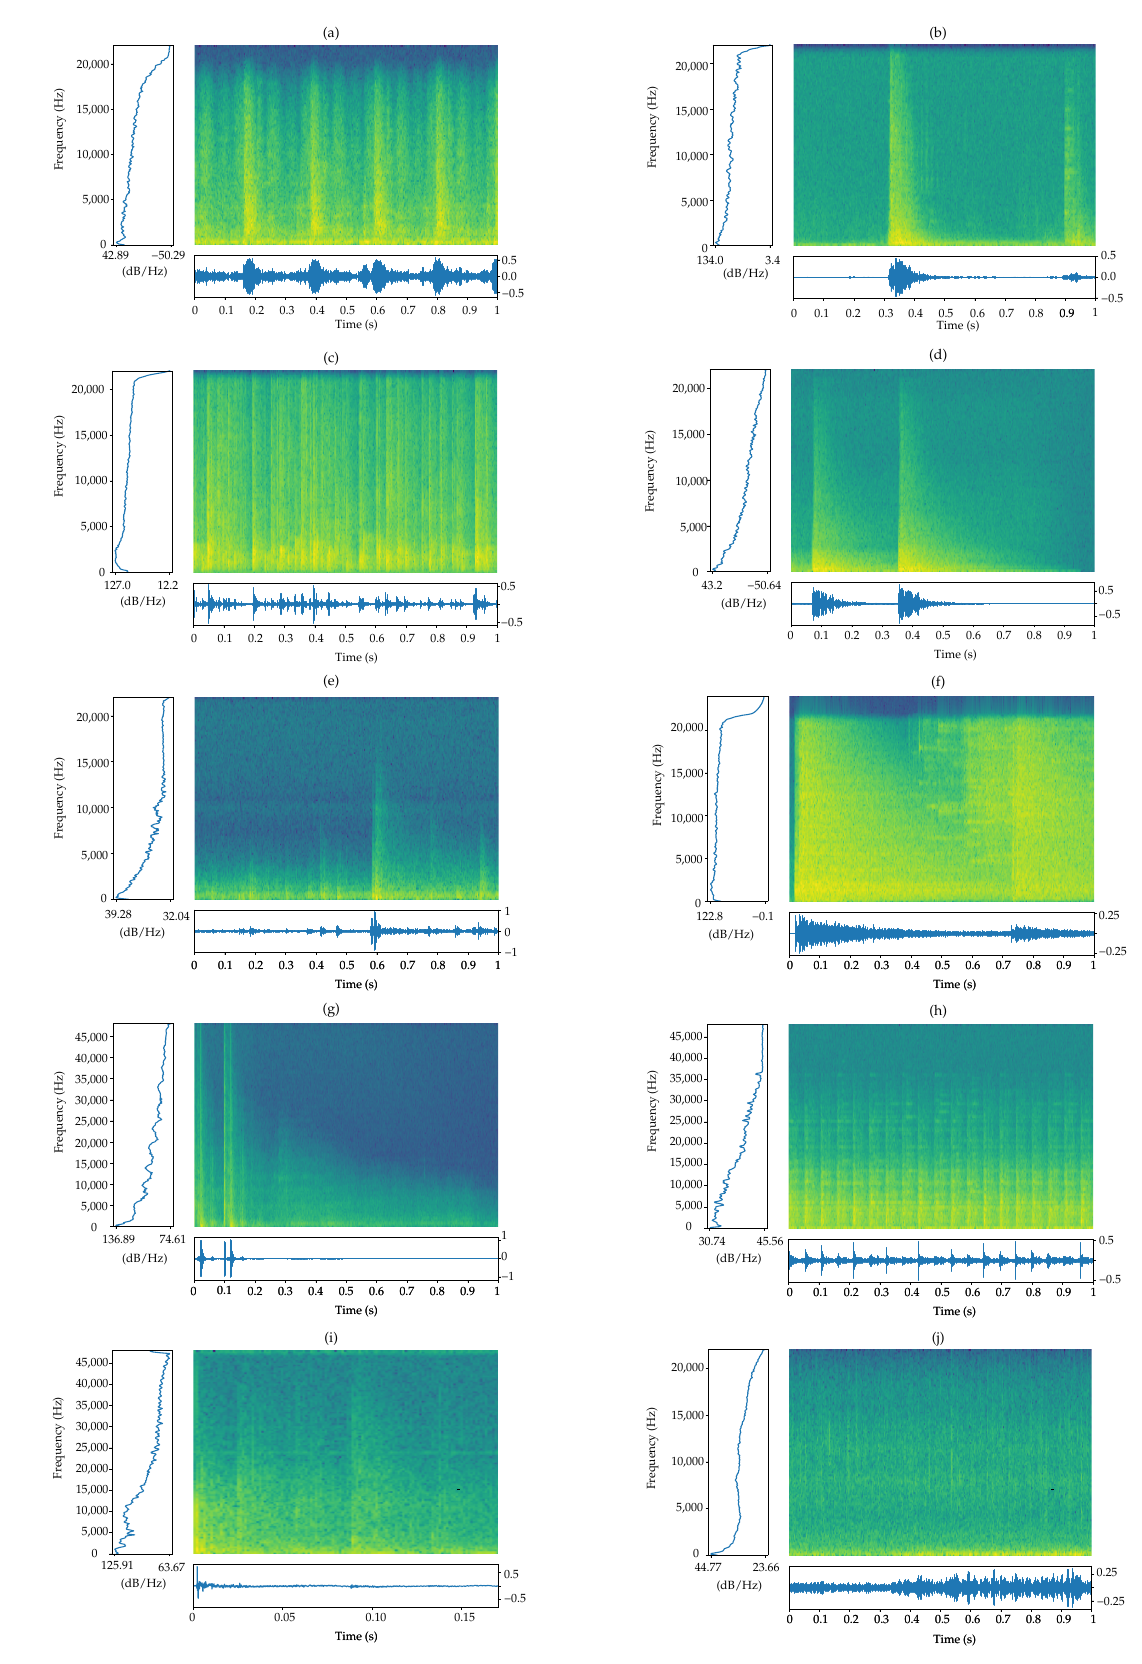
Figure 6. Comparison of the spectrograms and respective PSD for the various classes: ( a ) carbackfire-0, ( b ) cardoorslam-1, ( c ) clapping-2, ( d ) doorknock_slam-3, ( e ) fireworks-4, ( f ) glassbreak_bulb-burst-5, ( g ) gunshot-6, ( h ) jackhammer-7, ( i ) plastic_pop-8 and, ( j )